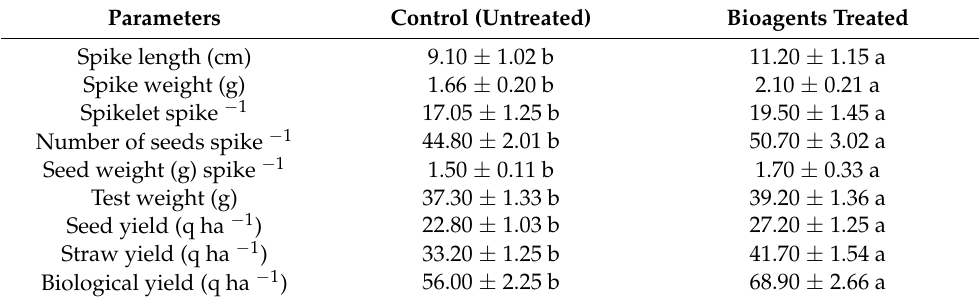
Figure 7. Effect of microbial inoculation on crop growth rate (CGR) in wheat grown in saline sodic soil under field condition at 30, 60, 90, 120 DAS. Data are means and vertical bar lines represent standard deviation. Double asterisk (**) represents significant difference, while single asterisk (*) represents non-significant difference with their respective control. Table 6. Effect of bioagents on yield and yield attributes of wheat grown under salt stress conditions at